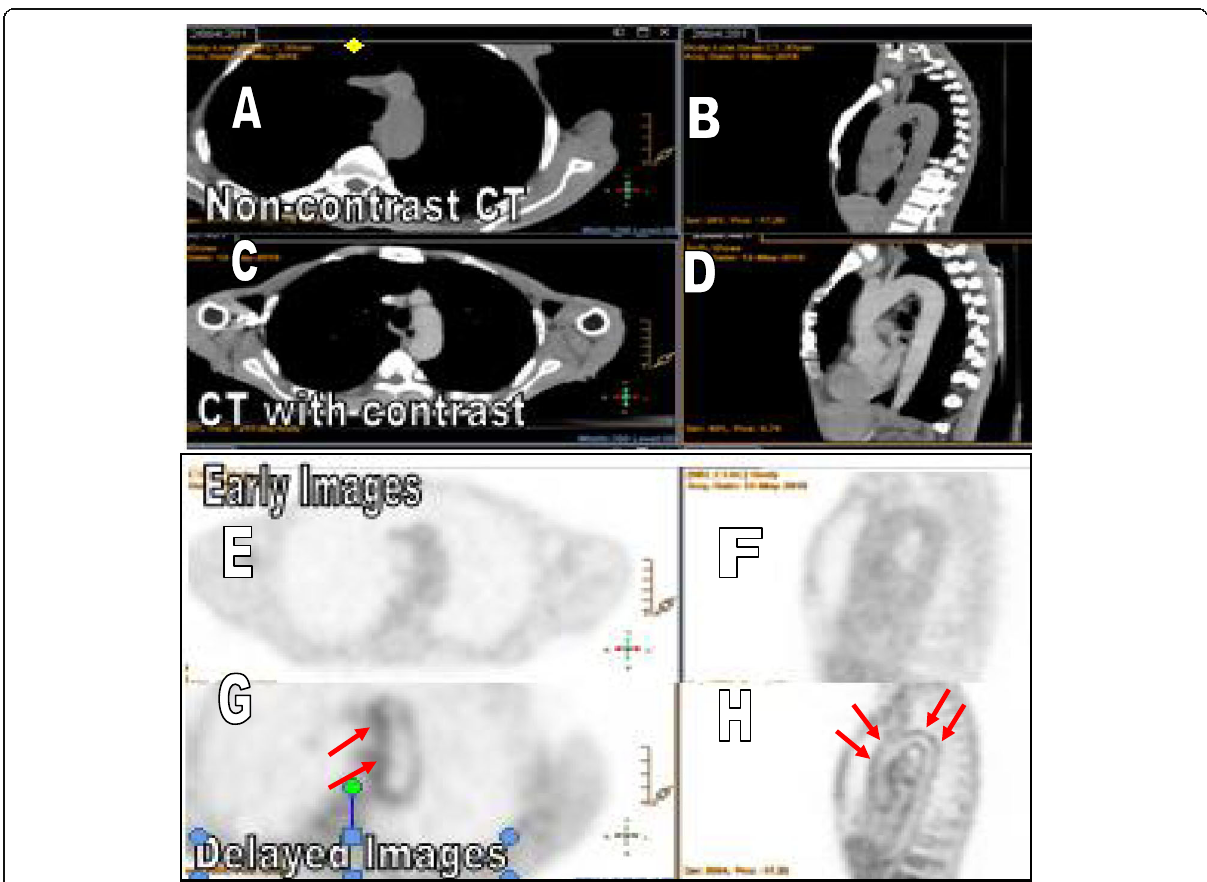
Fig. 3 Male patient 55-year-old, non-smoker, non-diabetic, non-hypertensive. He underwent PET/CT for nasopharyngeal cancer staging. Non contrast ( a , b ) and post contrast CT images ( c , d ) showed minimal intimal thickening of the thoracic aorta reaching 3 mm with no obvious calcification denoting early atherosclerotic disease. Note the difference between the early PET images ( e , f ) and delayed images ( g , h ) with retention of FDG within the aortic wall